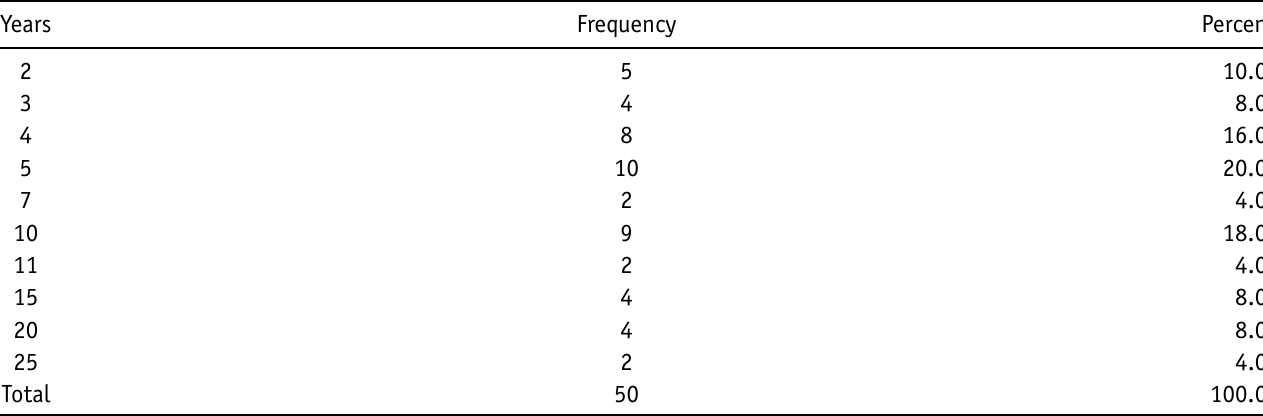
Table IV. Diagram 3 – Distribution as per duration of the habit in